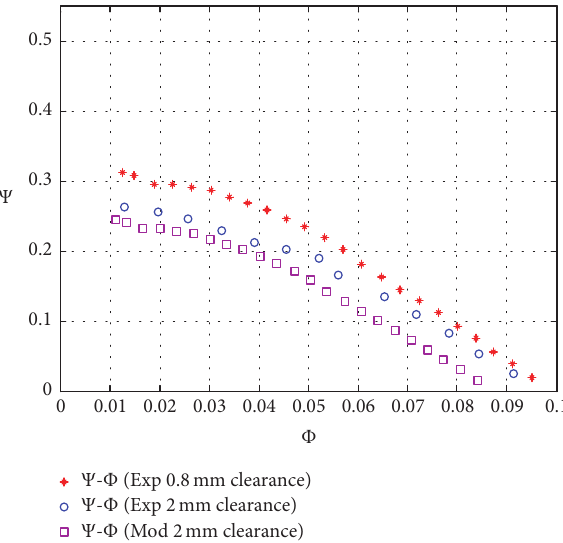
Figure 6: Hydraulic performances for the DAPROT3 inducer with different clearance values. For a clearance of 2 mm, also the results of the model used for scaling the performance are